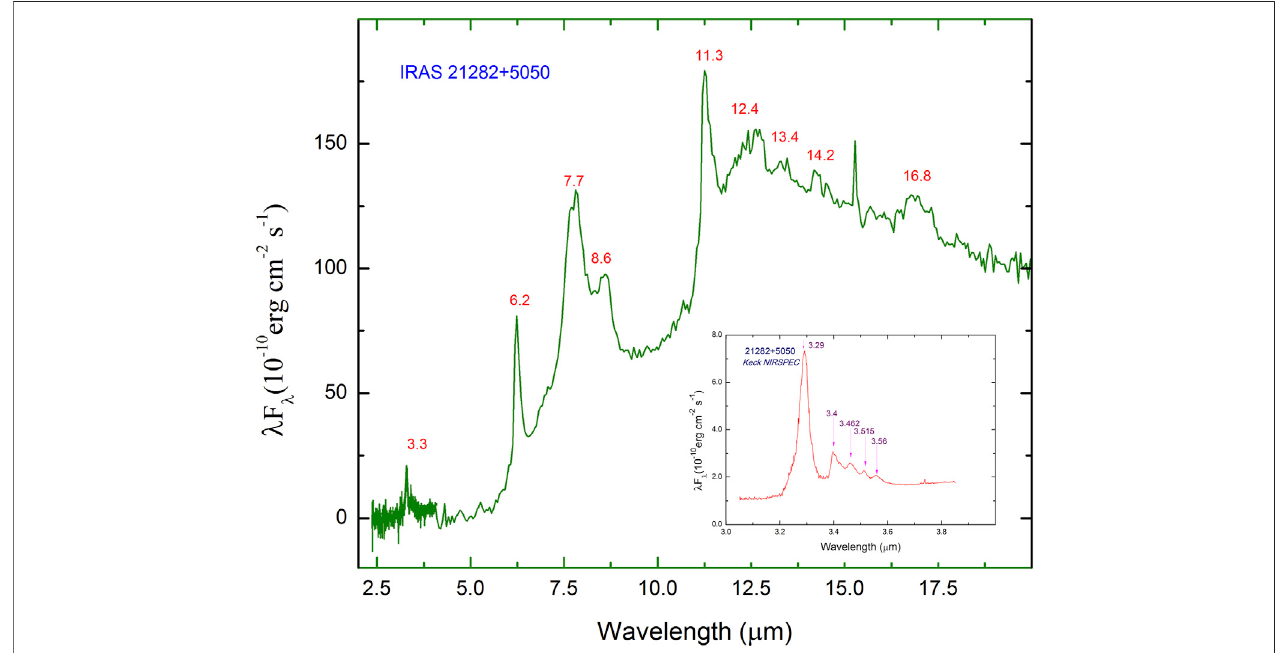
FIGURE3| Infrared Space Observatory spectrumofplanetary nebula IRAS 21282 +5050.The UIEbands (in unitsofµm) aremarked inred. Theinsert boxshows the expanded spectrum in the 3 µm region obtained with the Keck Telescope , where both the aromatic and aliphatic C – H stretch emissions can be